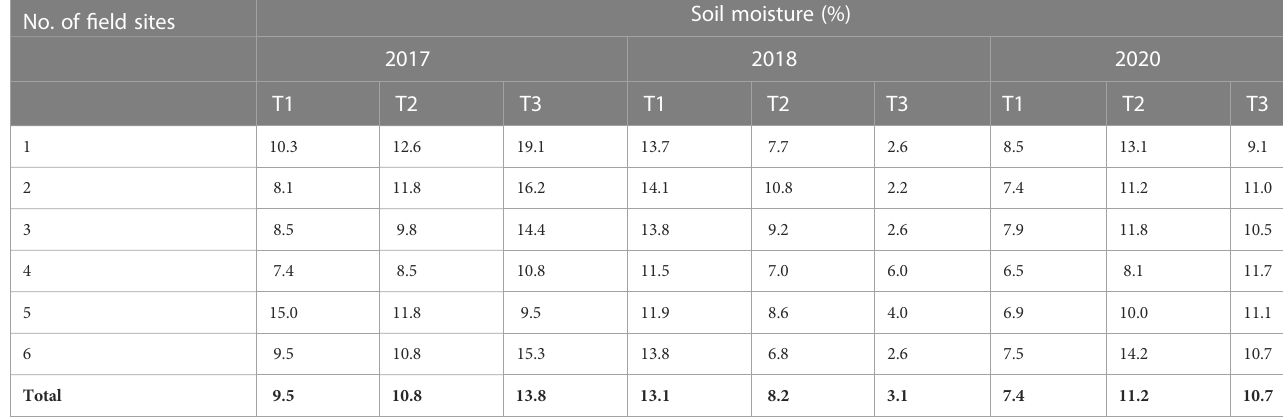
No. of fi eld sites Soil moisture